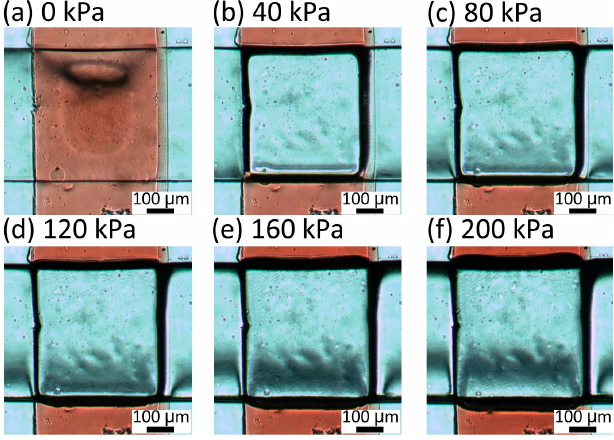
Figure 7. Center of intersection between the two microchannels of the microvalve with a 30- µ m-thick membrane under pressures of ( a ) 0; ( b ) 40; ( c ) 80; ( d ) 120; ( e ) 160; and ( f ) 200 kPa.